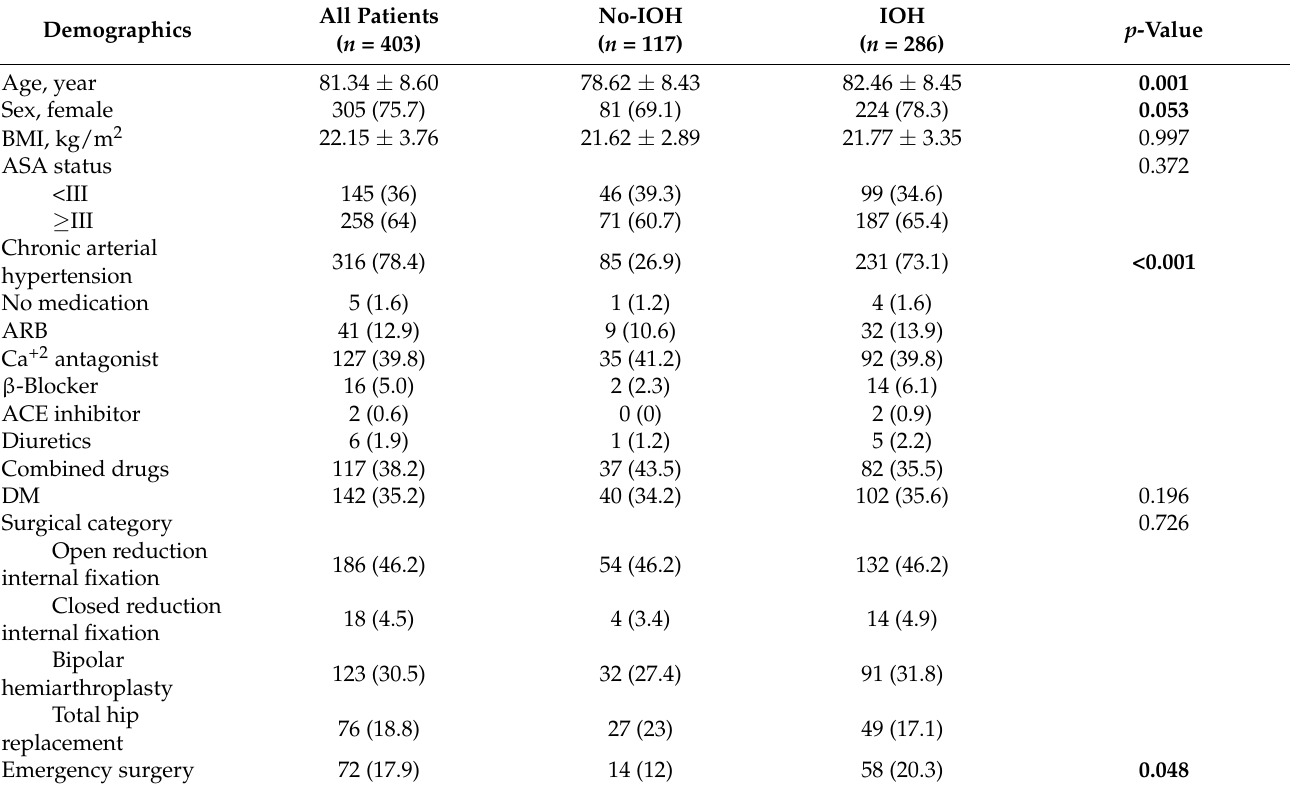
Table 1. Demographic and baseline characteristics of